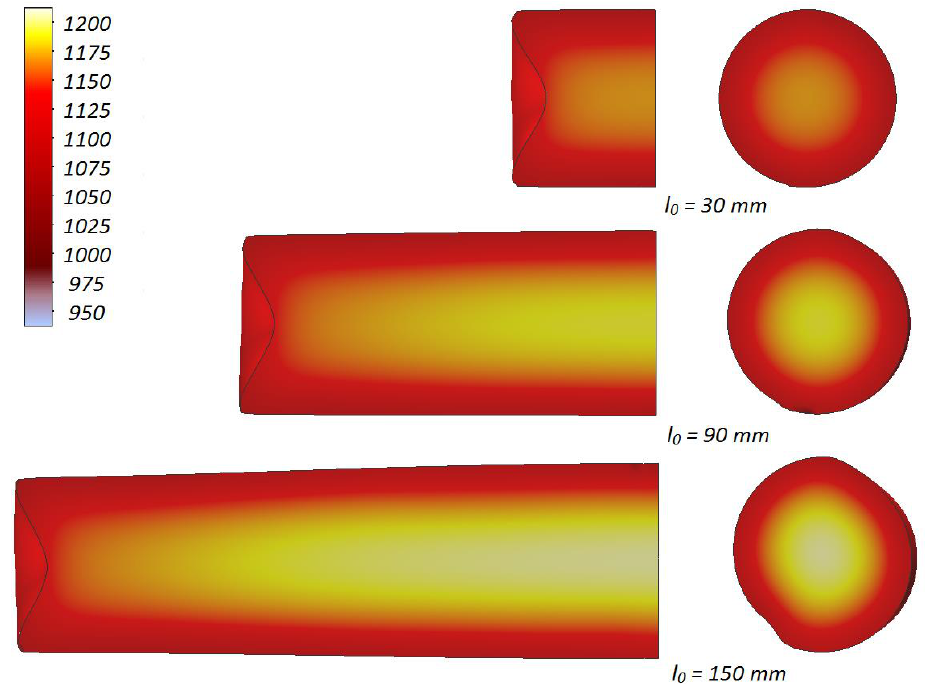
Figure 12. Distributions of temperature (w ◦ C) in samples with the initial length l 0 , heated to T = 1150 ◦ C and subjected to rotational compression in the path 315 mm; due to the symmetry of the process ½ samples was shown.